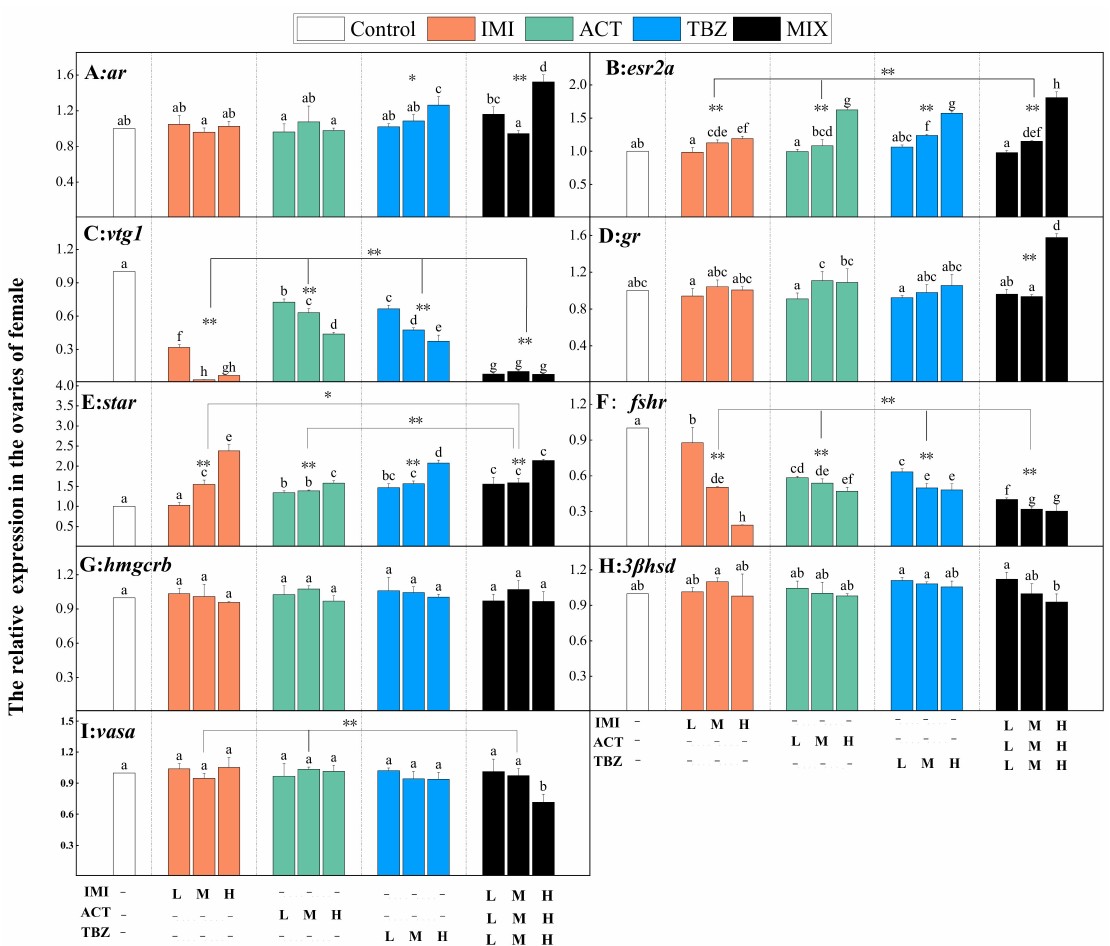
Figure 7. Expressions of reproductive genes ( A ) ar , ( B ) esr2a , ( C ) vtg1 , ( D ) gr , ( E ) star , ( F ) fshr , ( G ) hmgcrb , ( H ) 3 β hsd and ( I ) vasa in the ovaries of the females. Values are presented as mean ± standard deviation (n = 3) ( p < 0.05). Here L: low concentration, M: medium concentration and H: high concentration. In the figure, “a, b, c, . . . ” indicate that the results were analyzed by one-way ANOVA; “* and **” indicate the significant differences between the exposure groups and the control and the results were analyzed by two-way ANOVA (*: p < 0.05; **: p <